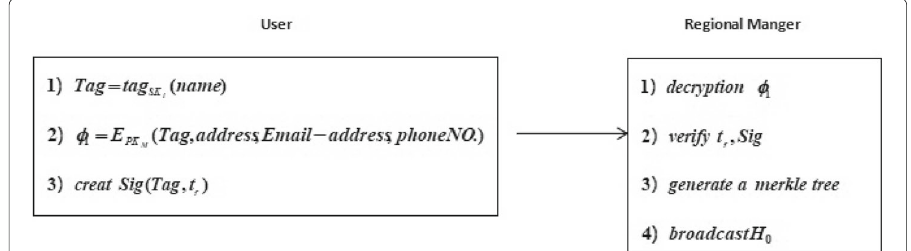
Fig. 3 Sketch of the protocol. This is an interactive protocol between the regional manager and the